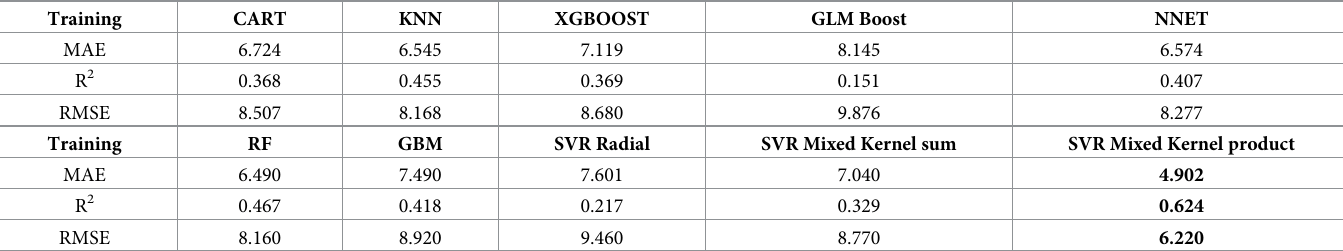
Table 2. Training performance comparison for different algorithms.